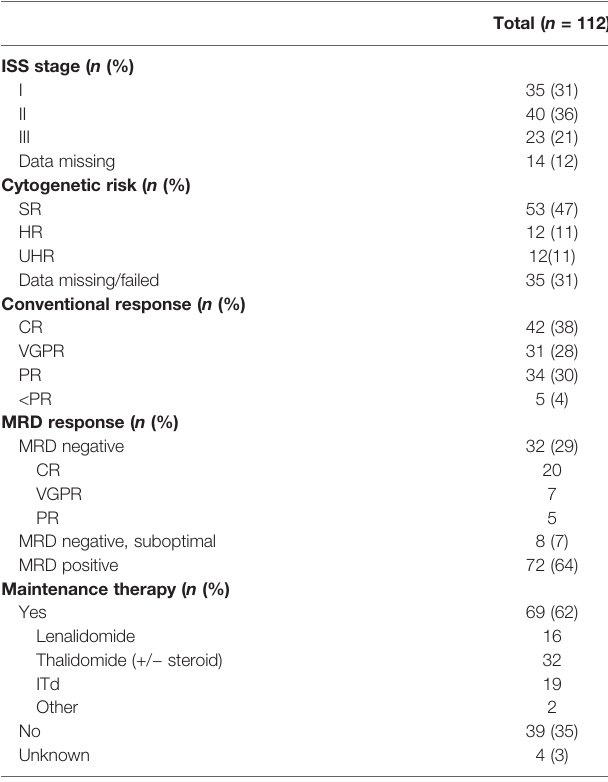
TABLE 1 | Disease characteristics, response, and maintenance